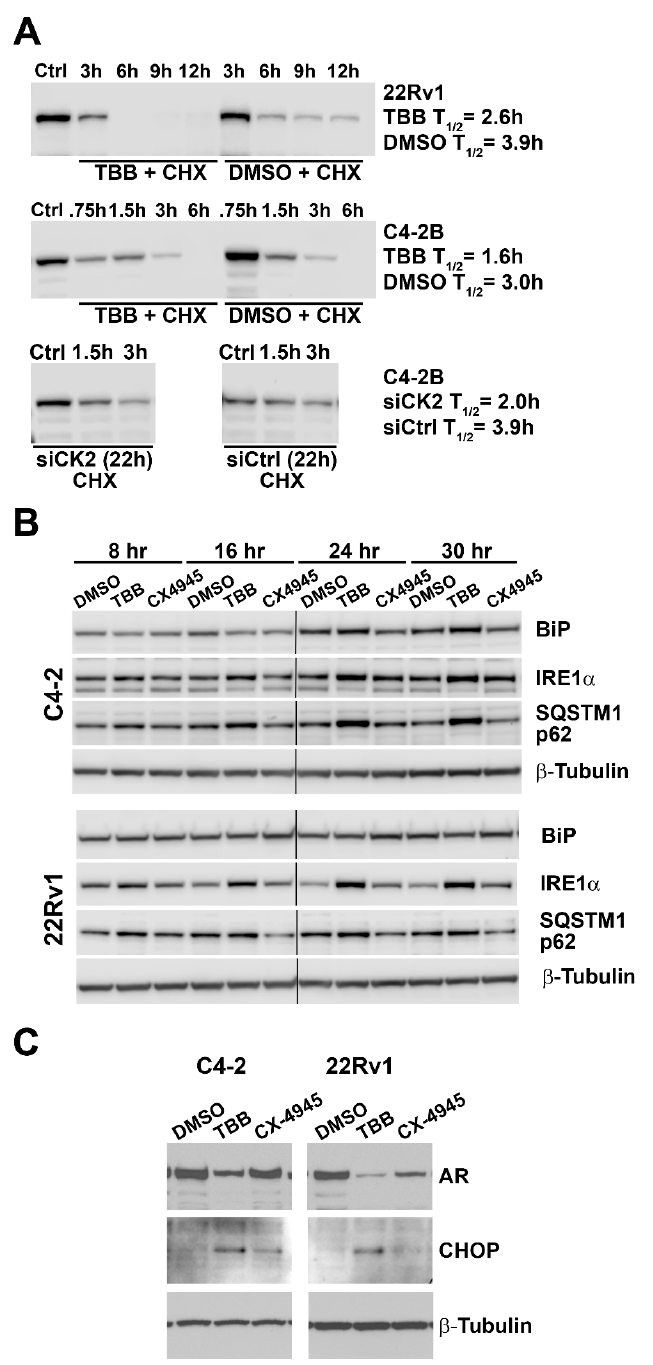
Figure 7. CK2 expression and activity influence AR protein half-life and ER stress signaling. ( A ) 22Rv1 and C4-2B cells were treated with 80 µM TBB or equivalent concentration of DMSO. C4-2B cells were also transfected with CK2 αα′ -targeted and control siRNAs. Twenty-four hours after TBB or DMSO treatment or 22 h post-transfection, cycloheximide was added to the culture plates, and cells were collected over time as indicated above the blot lanes. Cell lysates were analyzed by immunoblot for AR protein expression, and AR half-life was calculated by linear regression of the quantitated signals. ( B ) C4-2 and 22Rv1 sample lysates from the experiments presented in Figure 3B were analyzed for markers of ER stress and autophagy by immunoblot. (C) AR and CHOP signals were analyzed by immunoblot in C4-2 and 22Rv1 48 h lysates following treatment with TBB or